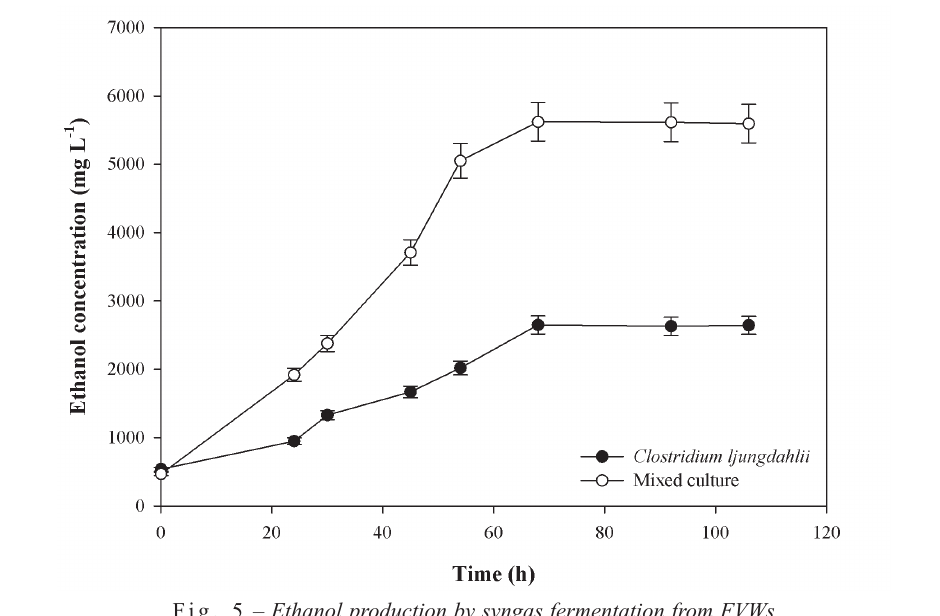
Fig. 5 – Ethanol production by syngas fermentation from FVWs